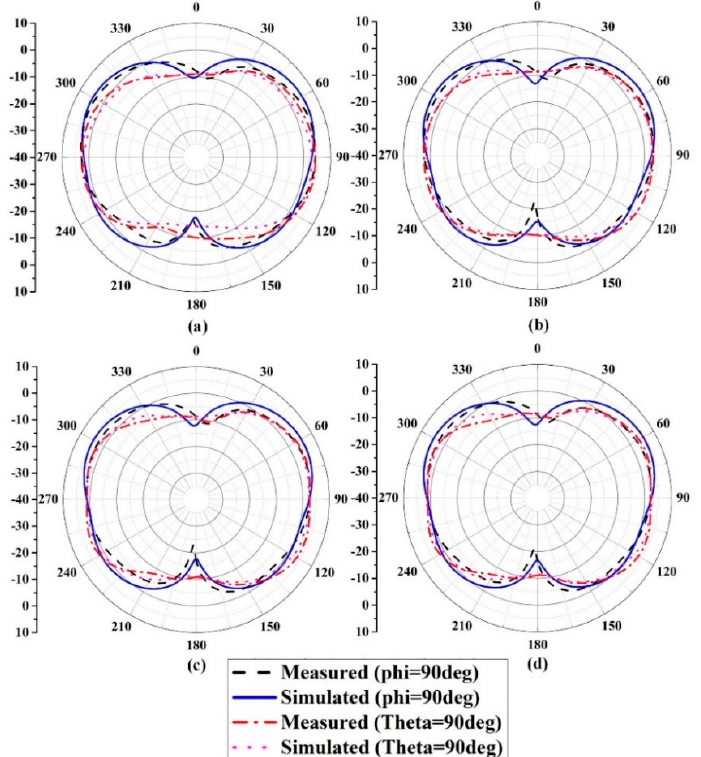
Figure 8. The simulation and test radiation patterns in the yoz plane (phi = 90degree) and xoy plane (theta = 90degree) at 4.3 GHz of the proposed eight-element MIMO excited separately by various antennas. ( a ) Ant 1; ( b ) Ant 2; ( c ) Ant 3; ( d ) Ant 4.